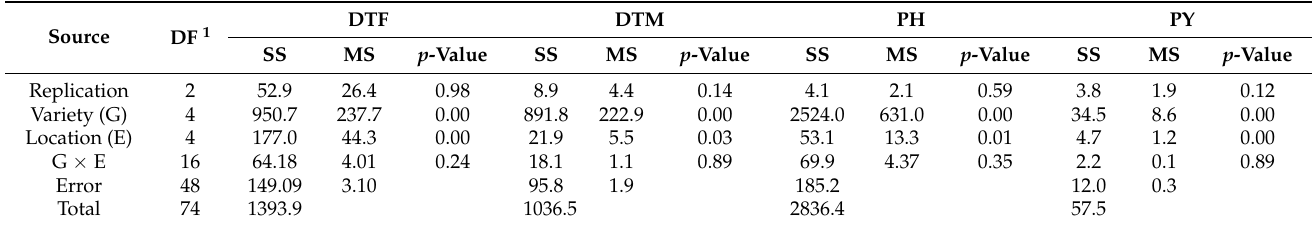
Table 2. ANOVA of response variables at 0.05% level of significance.